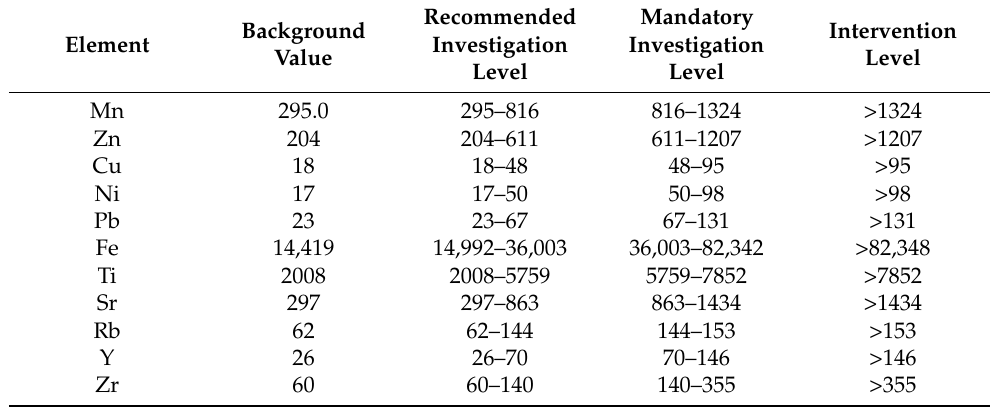
Table 4. Proposed pollution limits, reference concentrations (mg/kg), for heavy metals in urban dust in G ó mez Palacio